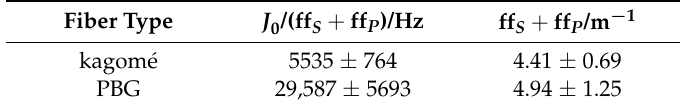
Table 4. Fit parameters for both types of fibers as well as the offset value for 0 m fiber length.